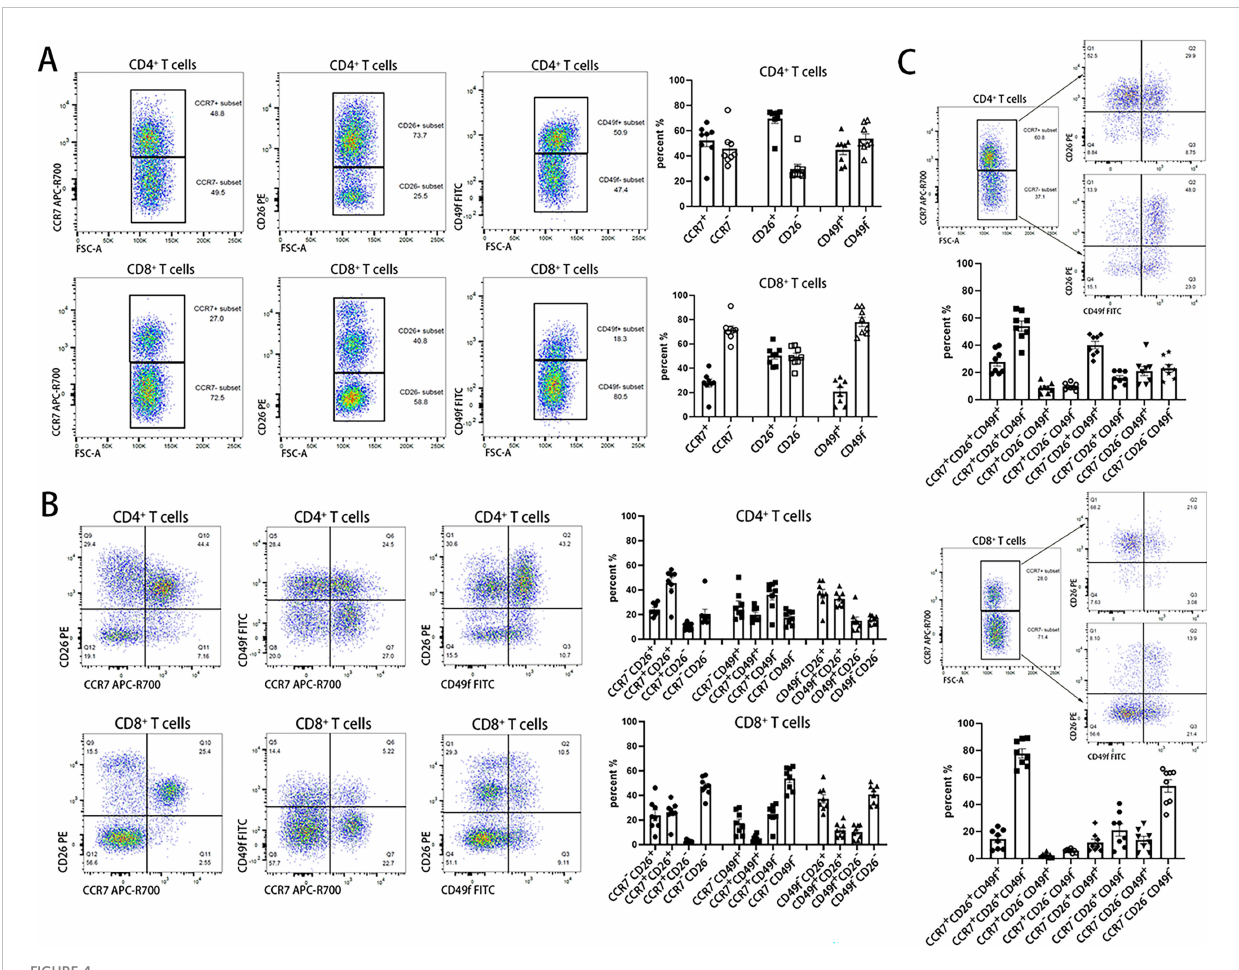
FIGURE 4 Three-layer classi fi cation of human T cells identi fi ed by CCR7, CD26 and CD49f. Three highly plastic molecules, CCR7, CD26, and CD49f are used to identify functional subsets in T cells. The 1 st layer in (A) , the 2 nd layer in (B) and the 3 rd layer in (C) use one, two and all three highly plastic molecules, respectively, to label the functional T-cell